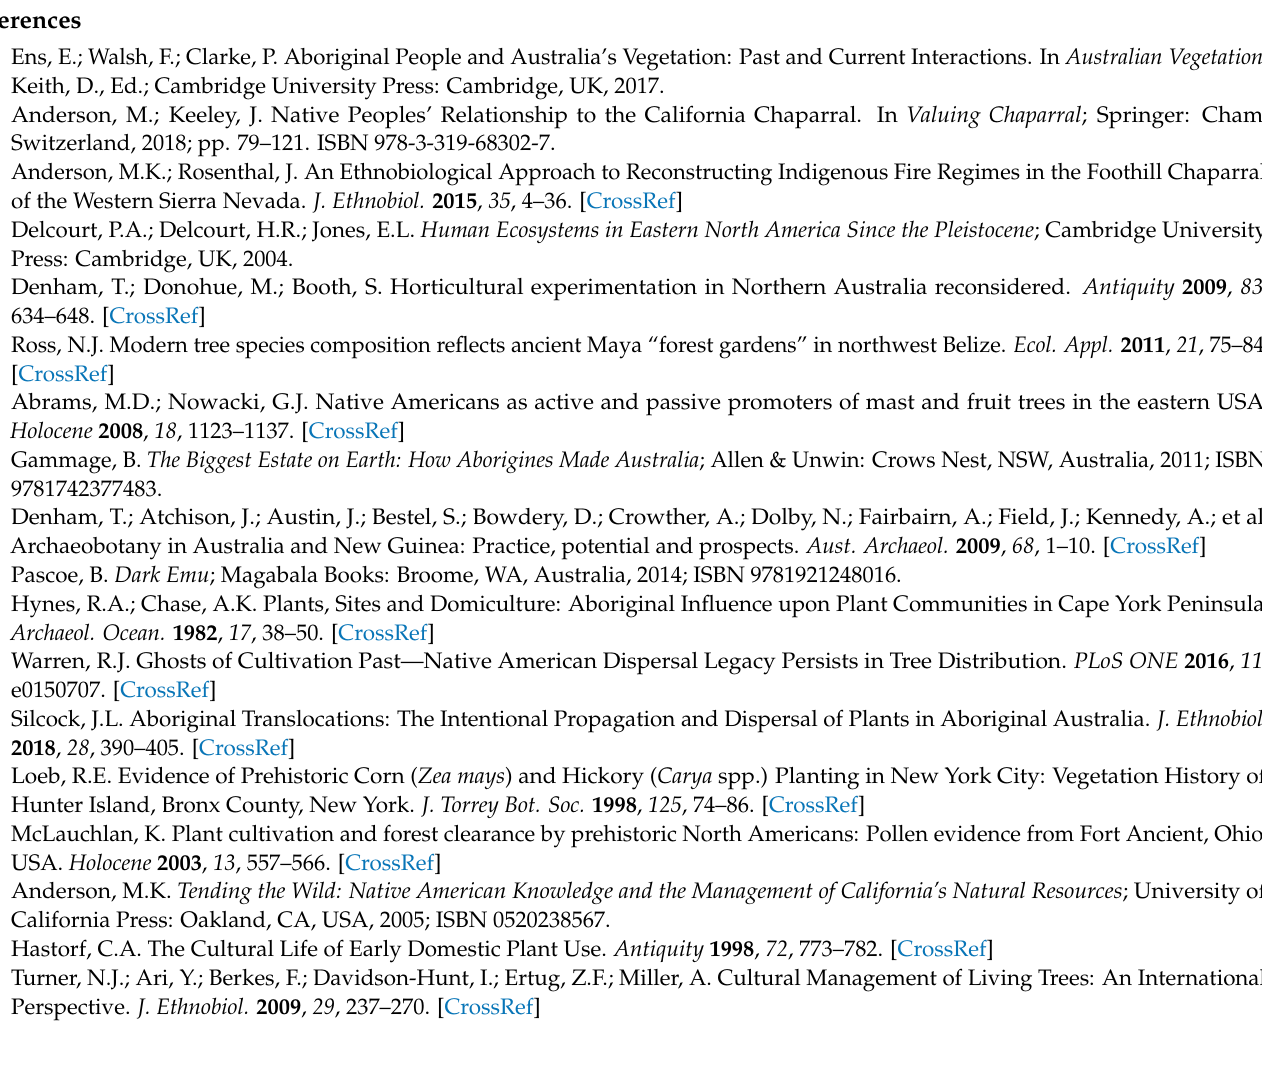
Figure A9. The mean pairwise Fst values calculated across 100 replicate simulations of a post-glacial faunal-mediated dispersal scenario (“hd6” in Table A1). This scenario of Indigenous dispersal assumes an asymmetric stepping-stone model of migration between 5000–4000 years ago.